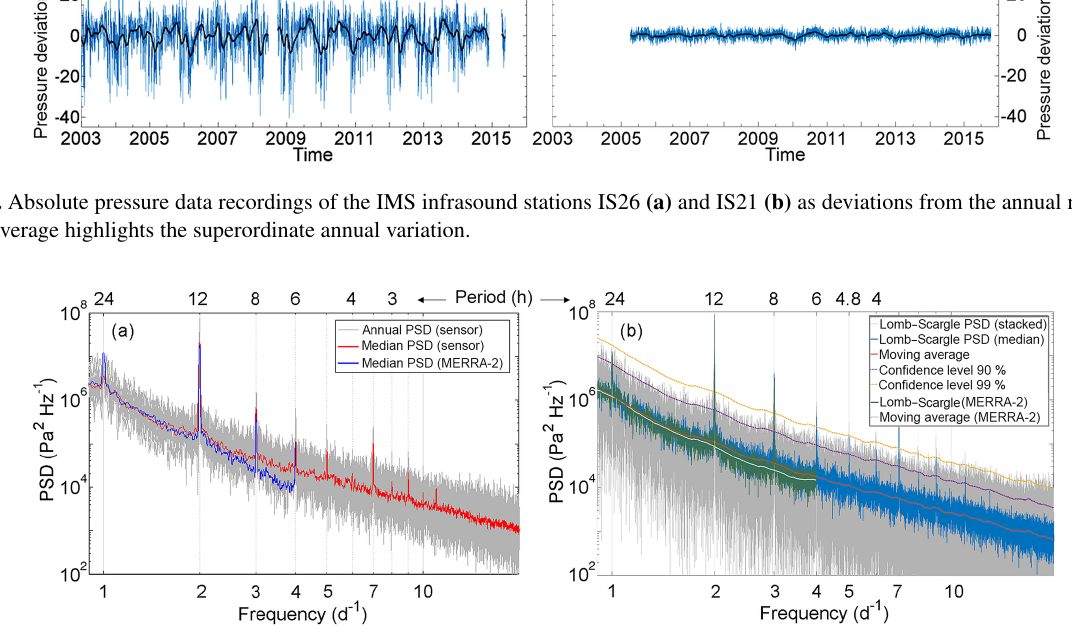
Figure 5. PSD plots for IS26. (a) The red curve depicts the median PSD for the entire period from 2003 to 2015 as derived from the barometric sensor. Each of the grey PSD curves belongs to a single year within this period. Panel (b) shows the Lomb–Scargle PSD spectrum based on the entire time series. In both panels, the solar tides appear as sharp peaks. The MERRA-2 reanalysis reveals a higher PSD for the diurnal